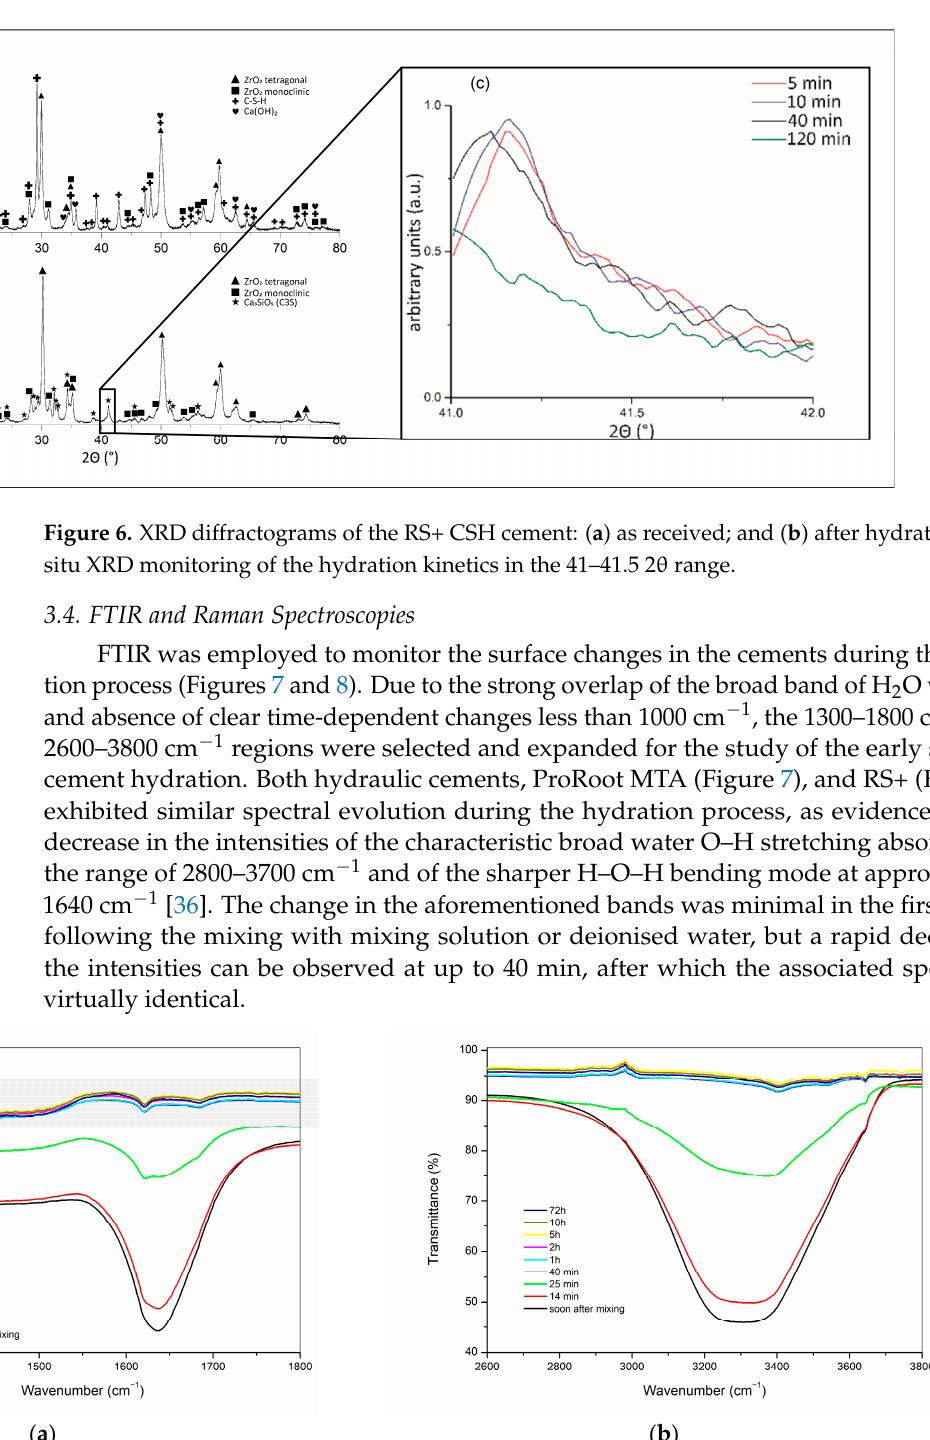
8 of 15 Figure 5. XRD di ff ractograms of the ProRoot MTA: ( a ) as received; and ( b ) after 48-h hydration.